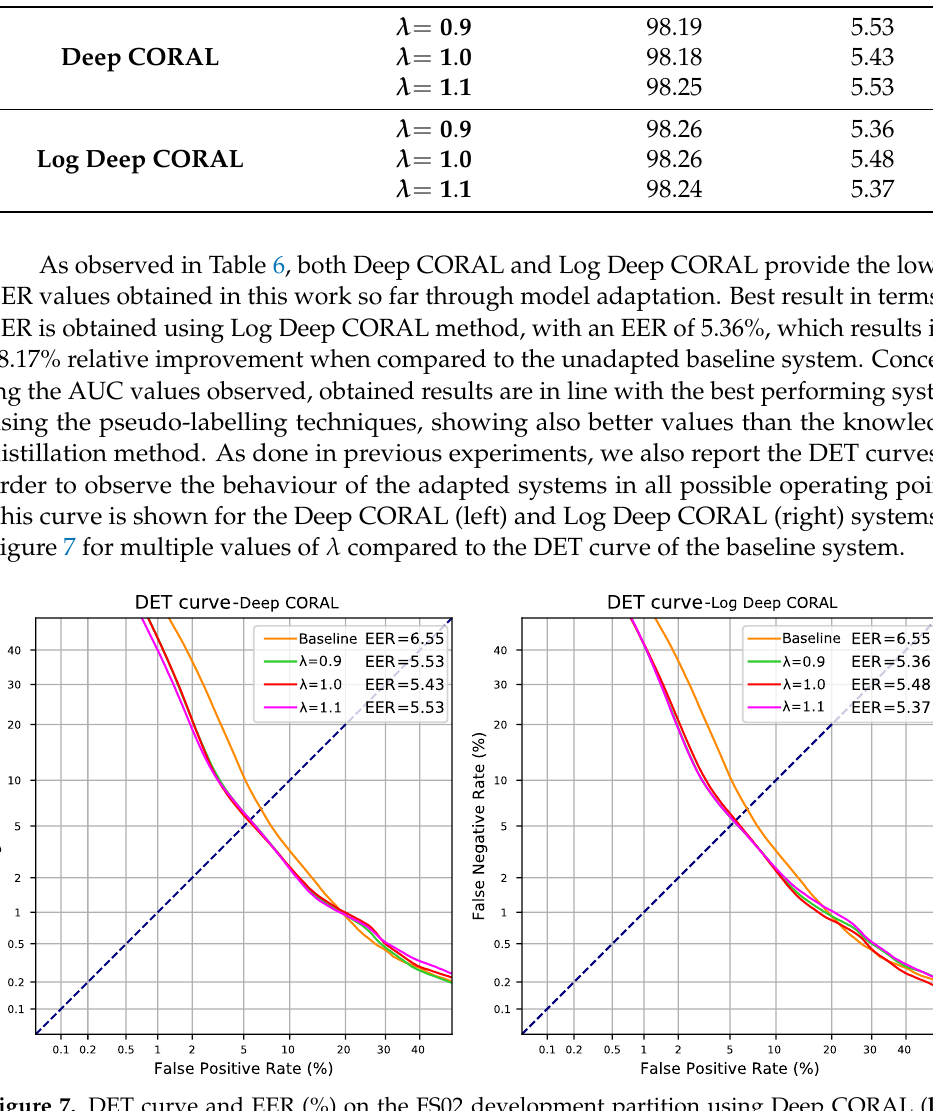
Figure 7. DET curve and EER (%) on the FS02 development partition using Deep CORAL ( left ) and Log Deep CORAL ( right ) domain adaptation setups using multiple λ weights compared to the baseline